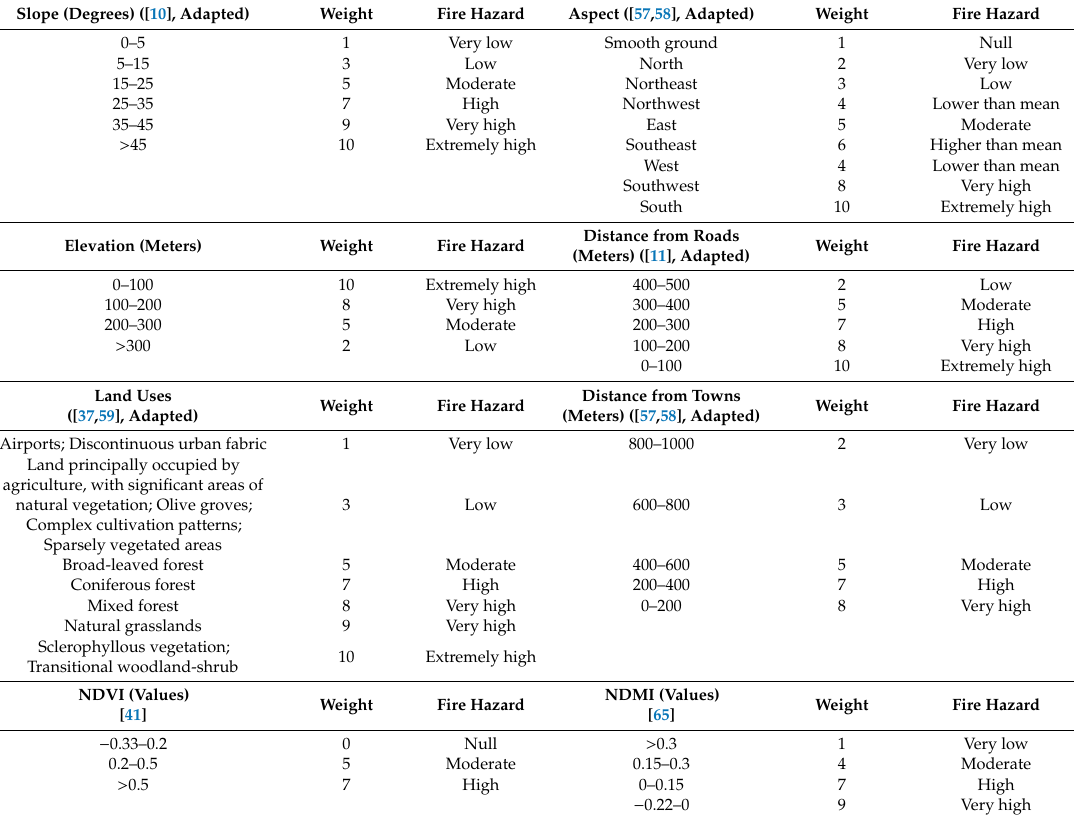
Table A1. Knowledge-based weighting of fire hazard factors.